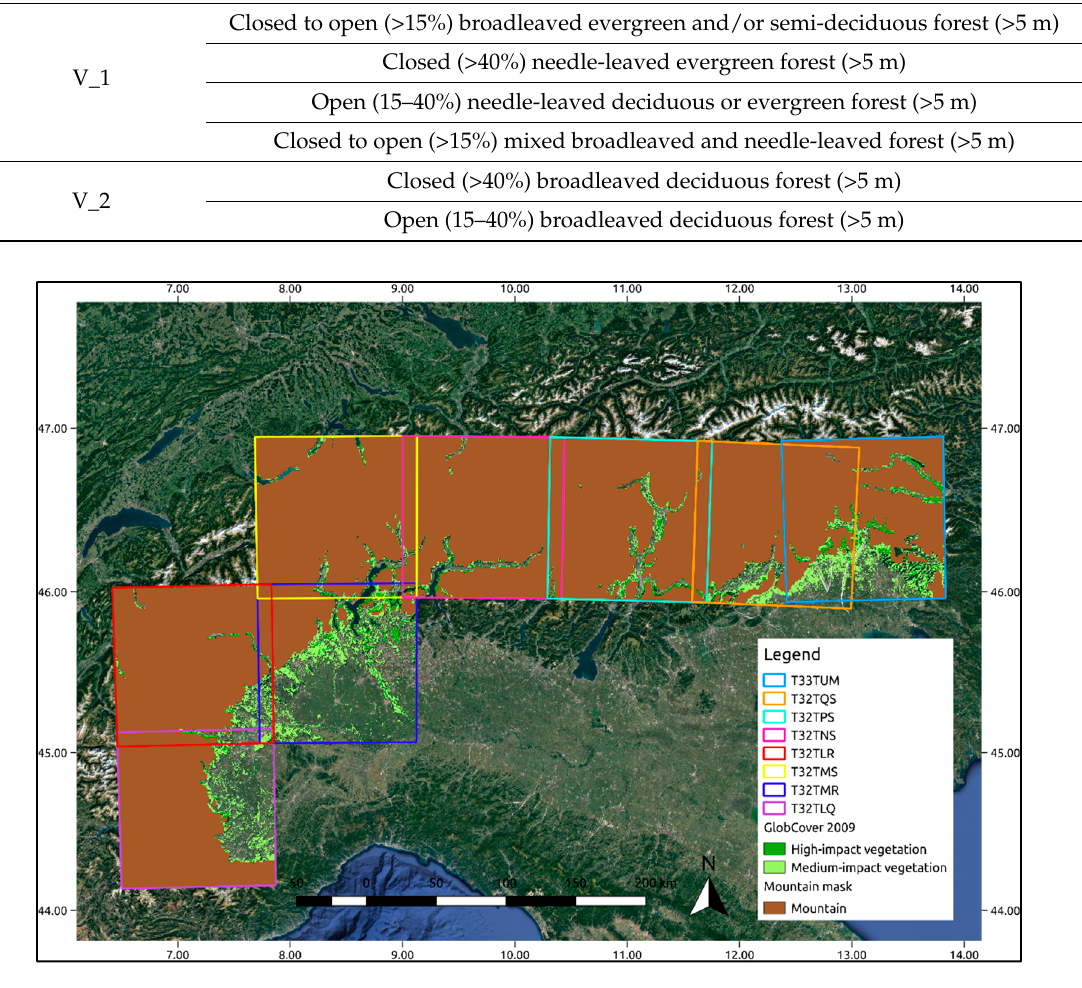
Figure 5. Selection of S-2 tiles in Finland.